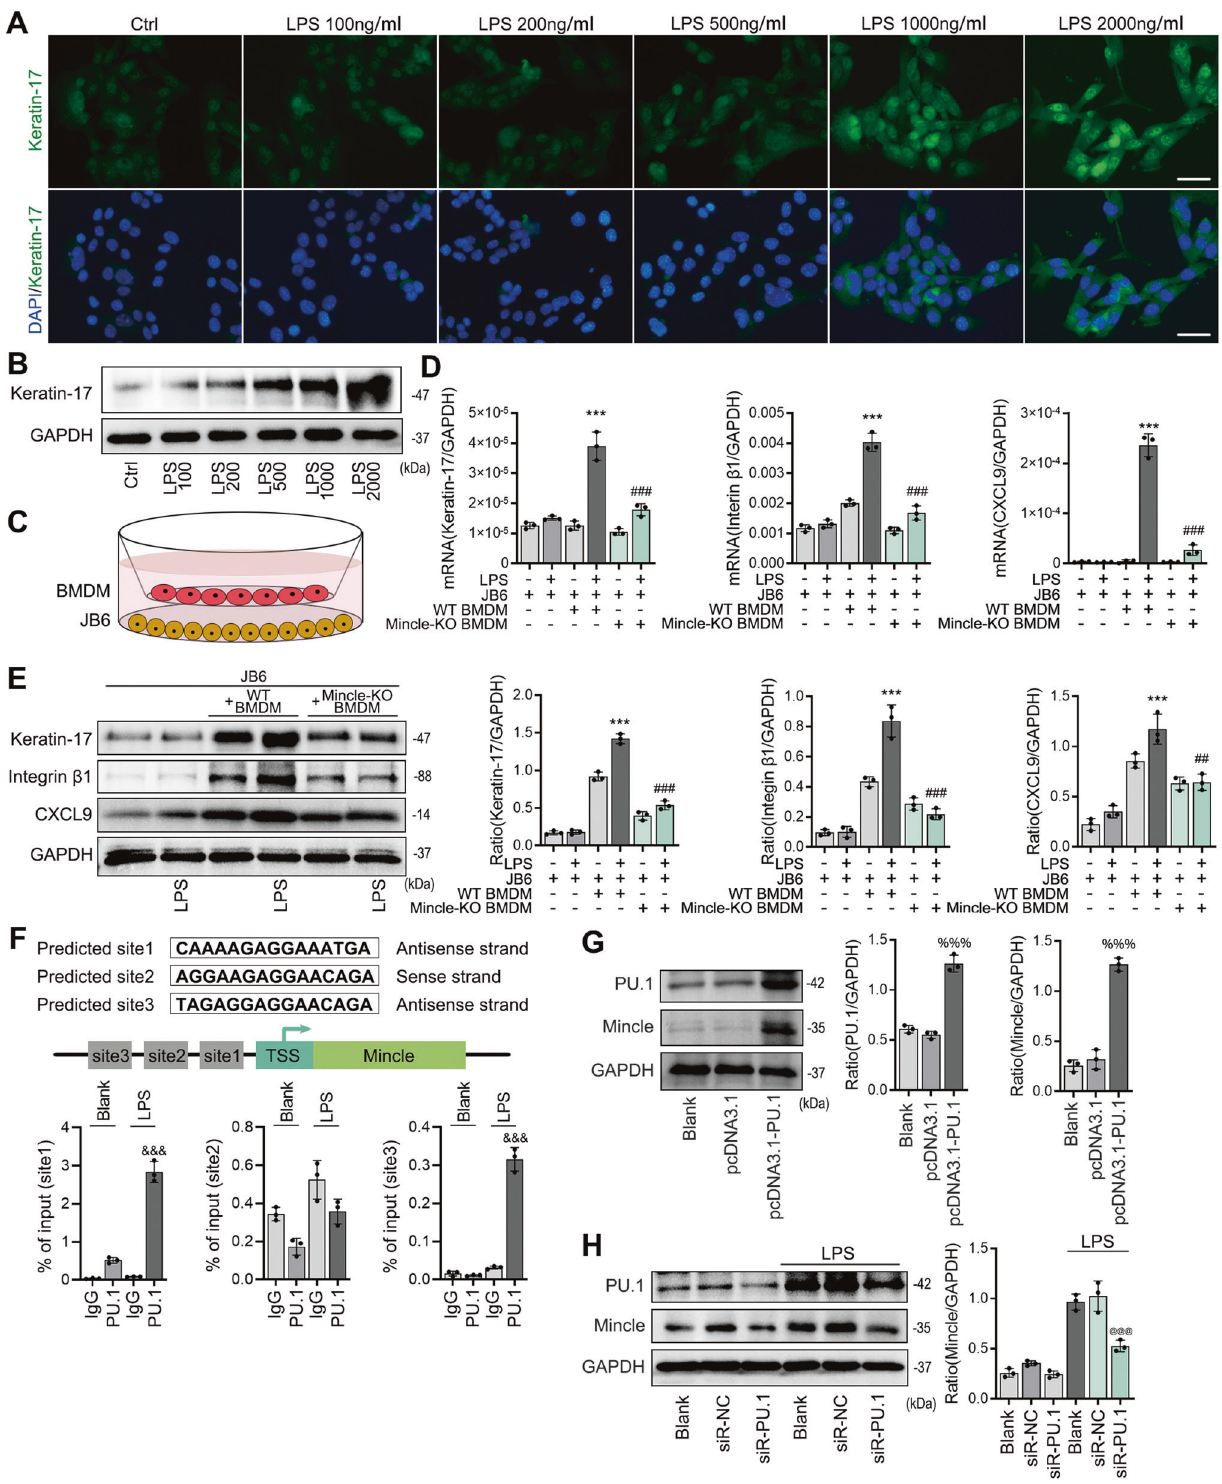
Fig. 6 Mincle mediates macrophage-dependent skin epithelial cell injury via a PU.1 mechanism in vitro. A Representative images of immuno fl uorescence staining of keratin-17 in LPS-stimulated JB6 cells. B Western blot showed the keratin-17 protein level in LPS-stimulated JB6 cells. C The co-culture system of BMDM and JB6 cells. D Real-time PCR detected the mRNA expression of Keratin-17, Intergrin β 1 and CXCL9 in JB6 co-cultured with or without BMDM. E Western blot detected the protein levels of Keratin-17, Intergrin β 1 and CXCL9 in JB6 co- cultured with or without BMDM. F The predicted binding sites of PU.1 on promotor of Mincle, and the ChIP results demonstrated the PU.1 bingding ability of each site on Mincle promoter. G Western blot results showed the protein levels of PU.1 and Mincle after overexpression of Mincle in BMDM cells. H Western blot results showed the protein levels of PU.1 and Mincle after knockdown of PU.1 in ctrl and LPS stimulated cells. n = 3 in each group. *** P < 0.001 vs. JB6 + LPS group; # P < 0.05, ### P < 0.001 vs. JB6 + BMDM + LPS group; %%% P < 0.001 vs. pcDNA3.1 group; @@@ P < 0.001 vs. LPS group. Cell Death Discovery (2023)